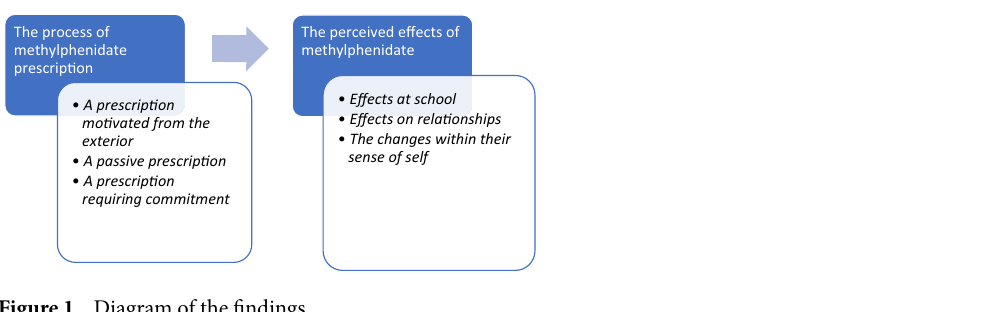
Figure 1. Diagram of the